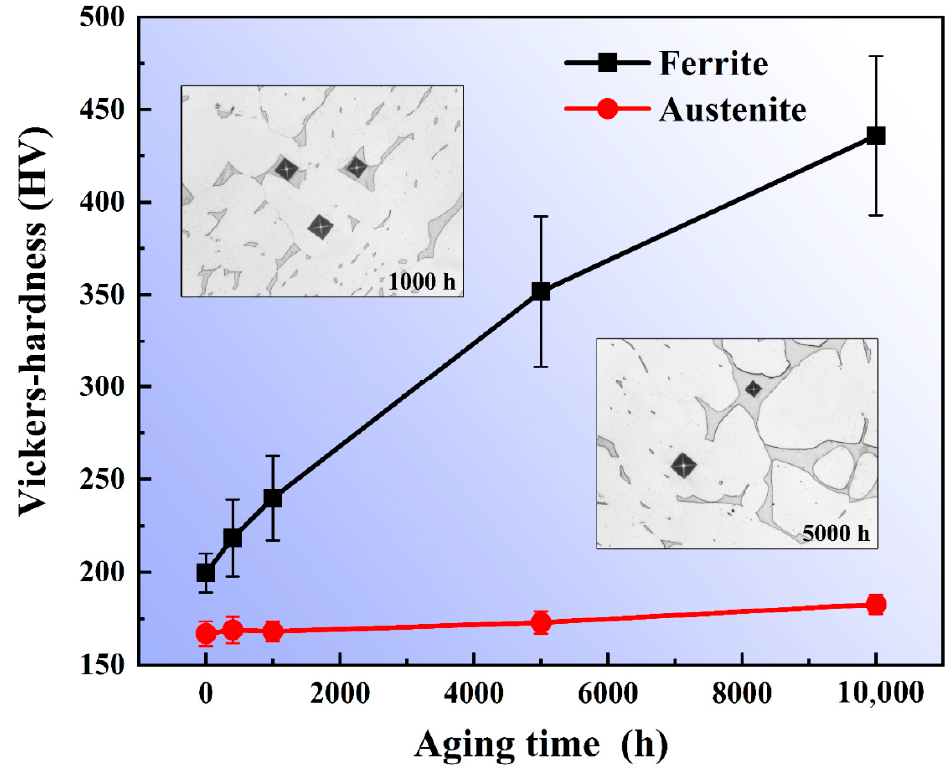
Figure 5. Microhardness of ferrite and austenite phases under different thermal aging time.